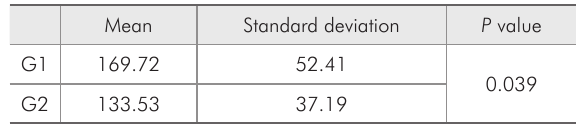
Table. 4. - Descriptive statistics for Vickers microhardness